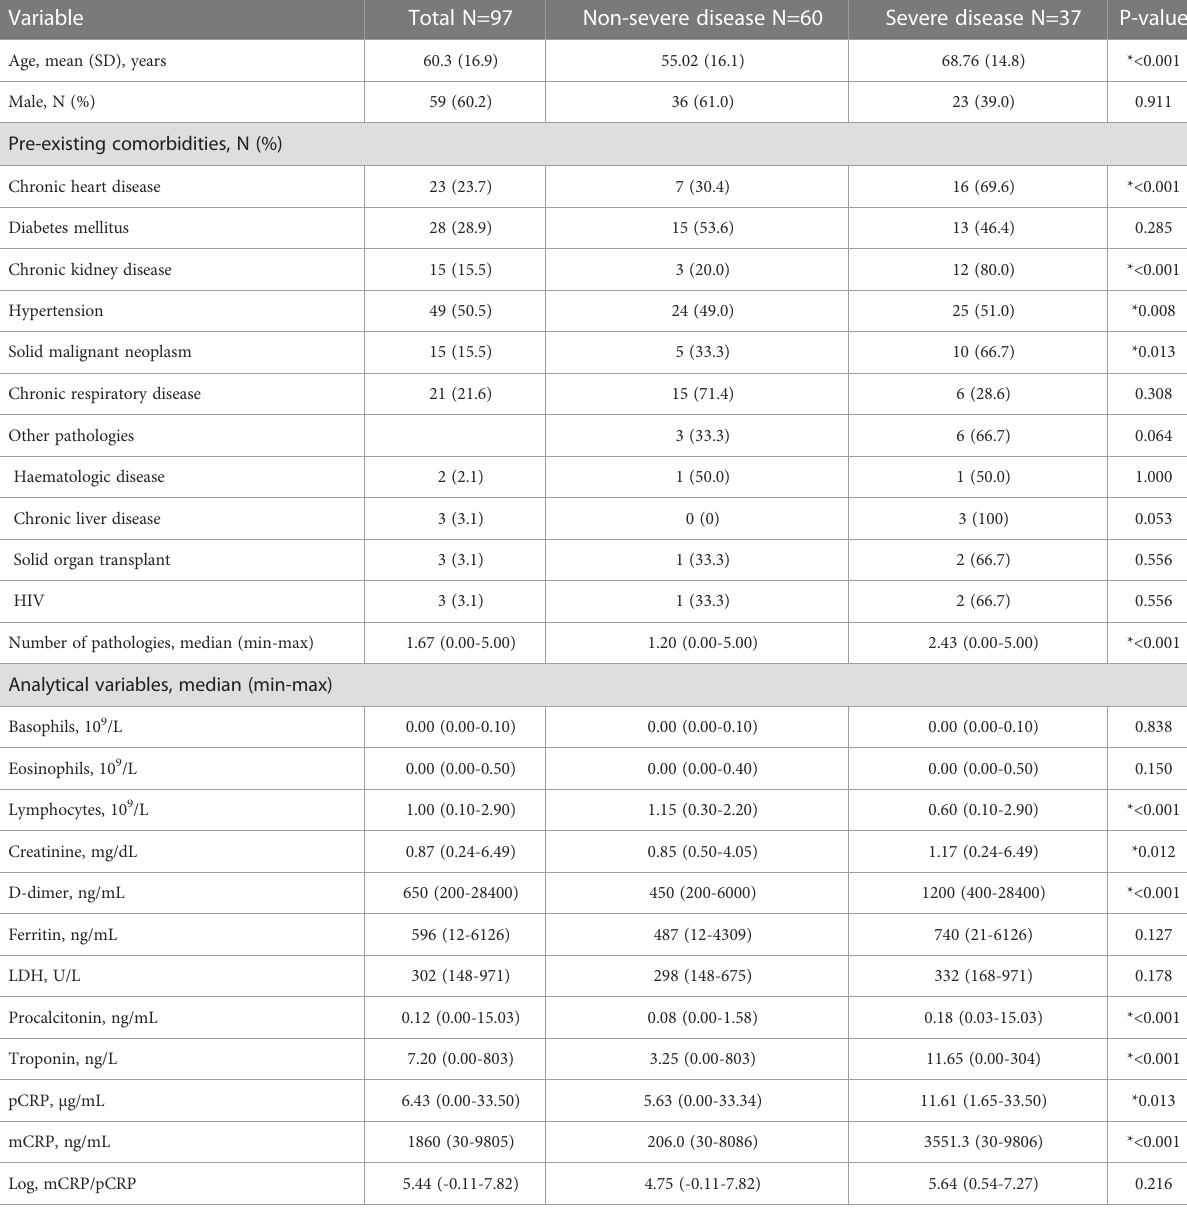
TABLE 1 Clinical and analytical features of COVID-19 patients upon admission and signi fi cant risk factors for disease severity (ICU admission and/or in-hospital mortality) on bivariate analysis.